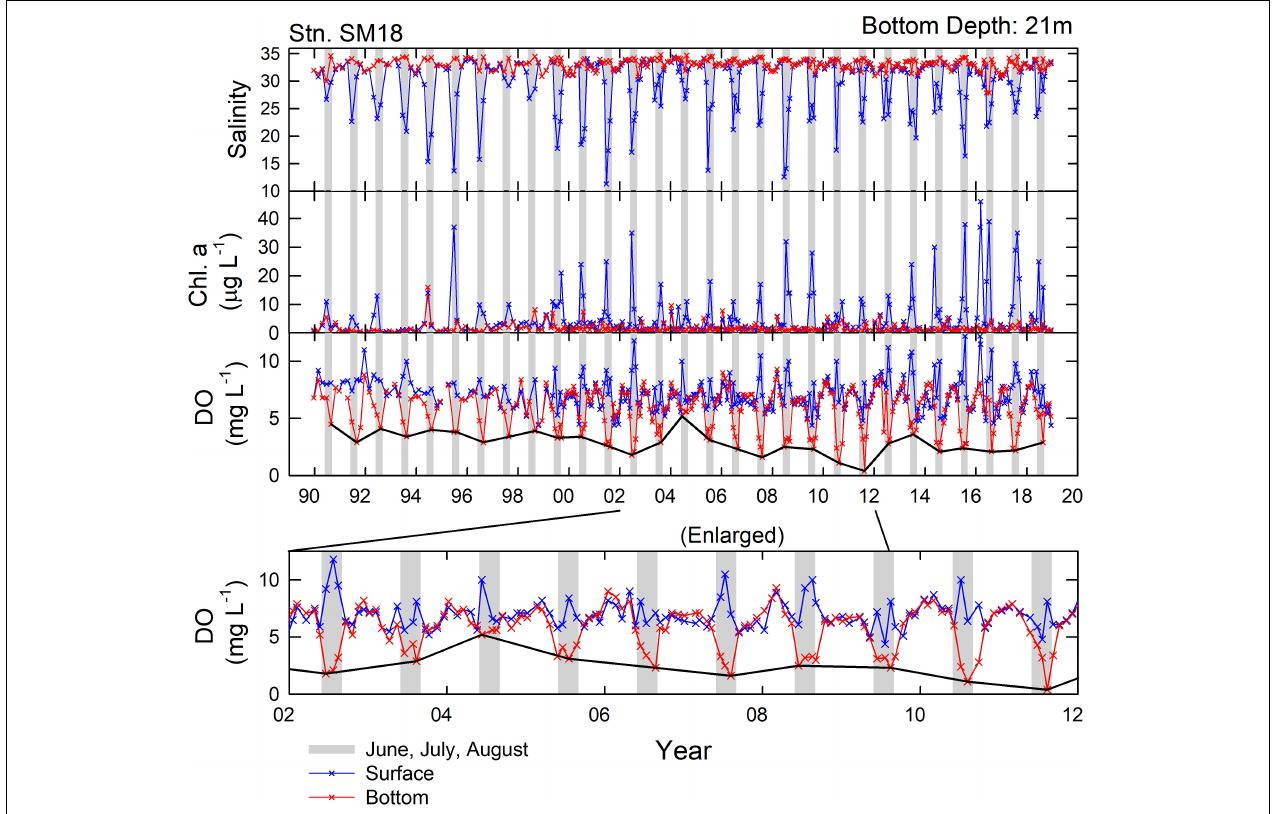
FIGURE 3 | Time series of salinity and chlorophyll-a and DO concentrations in surface and bottom waters at SM18 between 1989 and 2018. The solid black line shows the DO min . Gray bars indicate the periods of June to